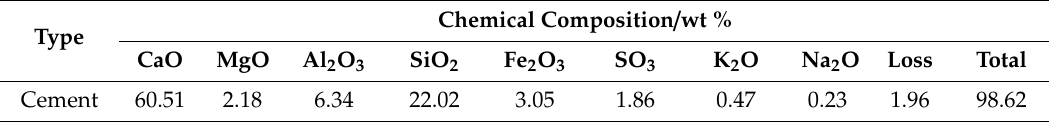
Table 1. Chemical composition of